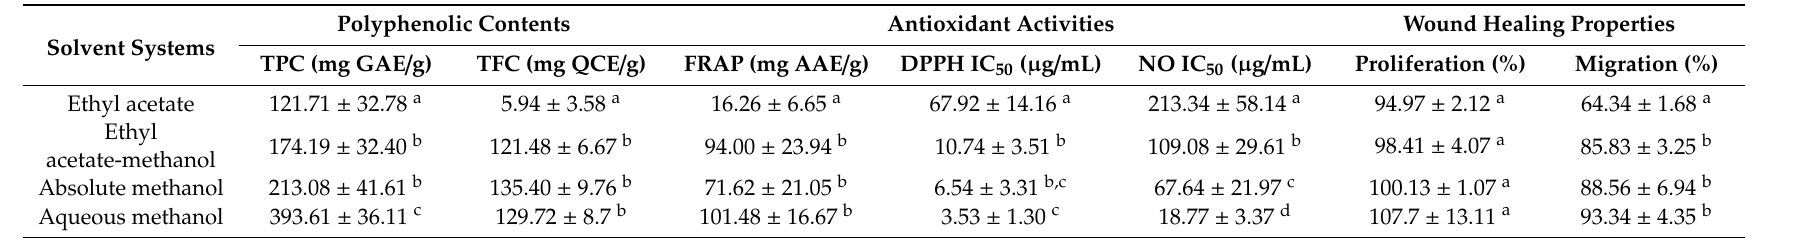
Table 2. Phenolic contents, antioxidant, and wound healing properties of di ff erent OPL extracts.